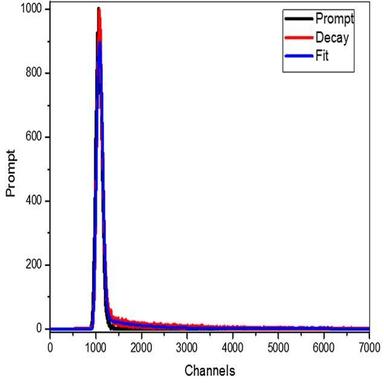
Fluorescence lifetime spectrum fit of PCOH.